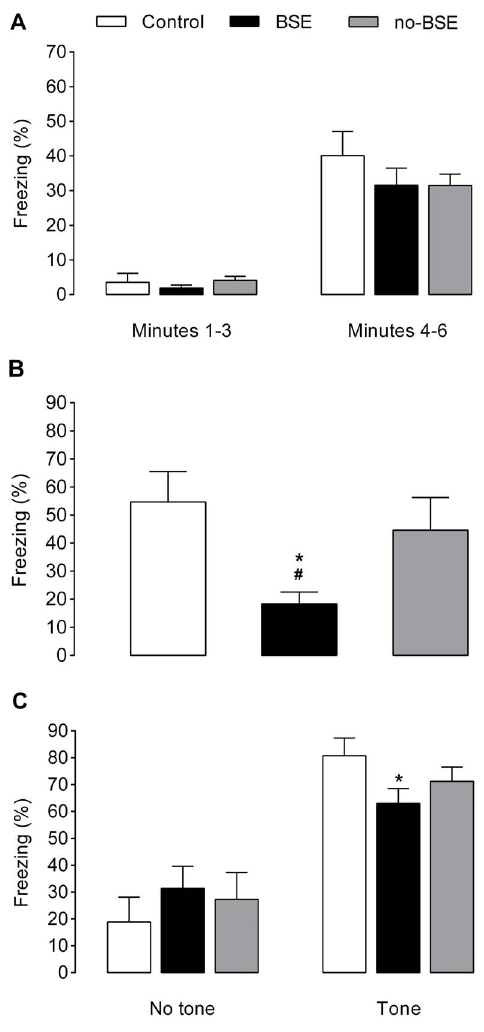
Figure 3. Effects of kainate treatment on the acquisition and retention of conditioned fear. The y-axes represent percentage of freezing time for each of the 3-minute periods of the acquisition session ( A ), during the context retention test ( B ), and during each of the 3- minute periods of the tone retention test which was performed in a novel context ( C ). No tone or footshock was delivered during the first 3- minute periods of the acquisition session ( A ) and of the tone retention test ( C ). Note that rats that had experienced behavioral status epilepticus (BSE group) showed reduced levels of fear, freezing significantly less than control rats on both retention tests. However, no-BSE group (composed of rats that had not experienced behavioral status epilepticus after kainate treatment) and control group did not differ significantly on these tests. * p , 0.05 vs. control group and # p , 0.05 vs. no-SE group. Data are presented as the mean 6